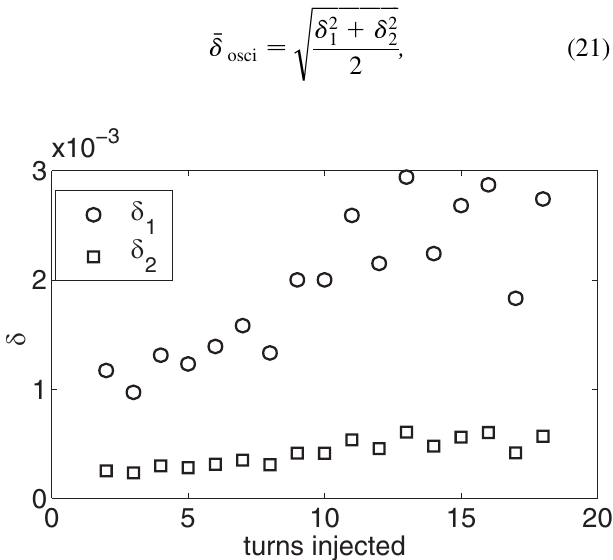
FIG. 23. The deduced mismatched rms momentum spread of and (cid:5) . the beam (cid:5) 1 2